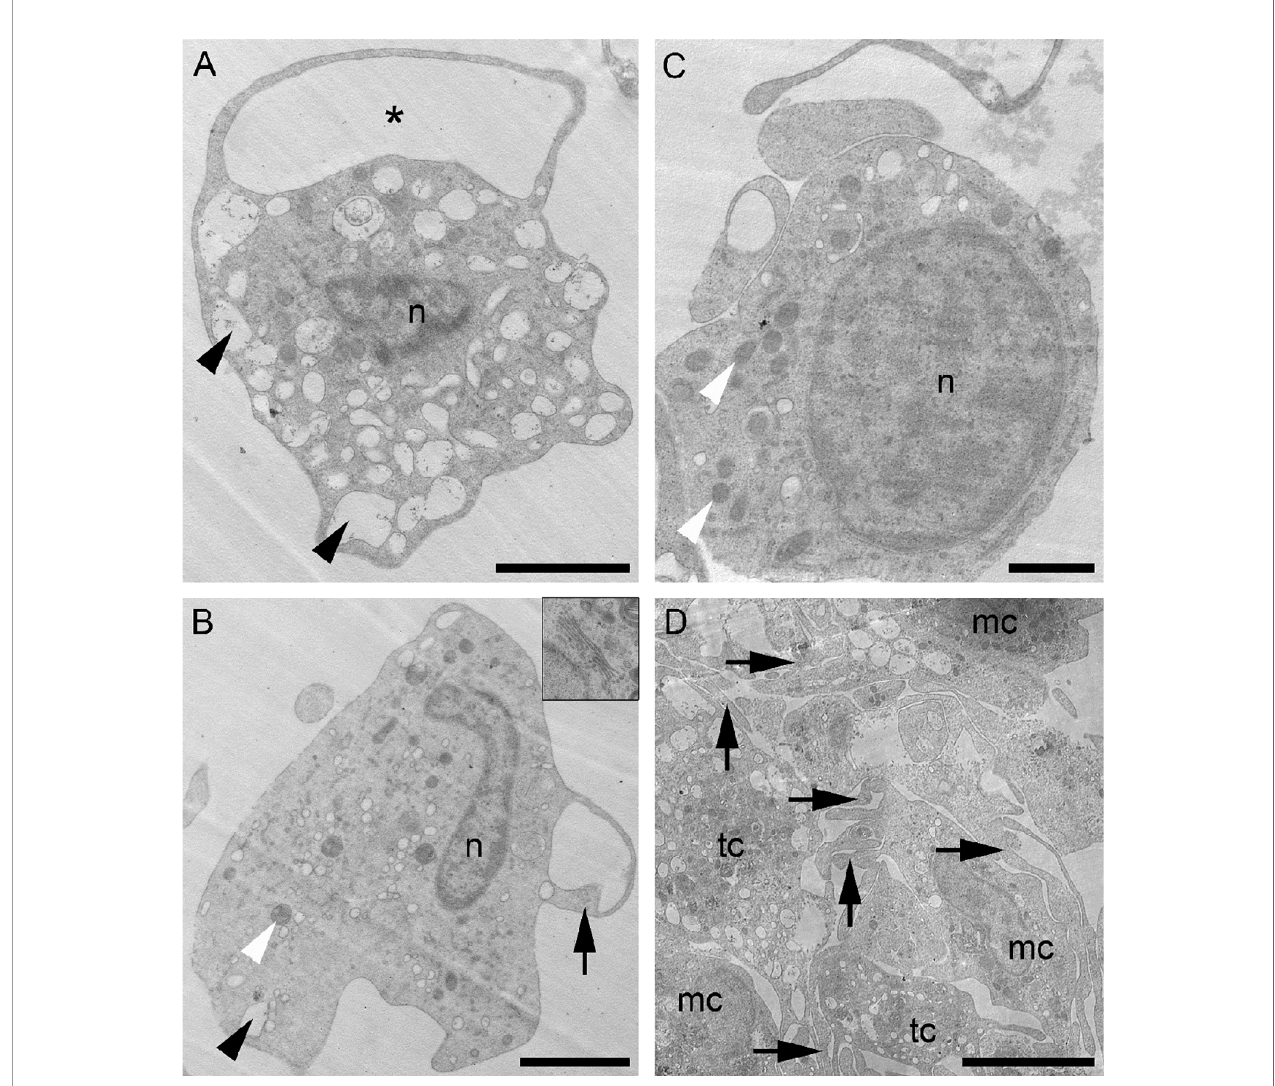
FIGURE 6 | Coelomocytes morphology by transmission electron microscopy. (A) Thrombocyte-like cell (tc) full of roundish electron-lucent vesicles (arrowheads) and with a cell process forming a loop (asterisk). (B) Macrophage-like cell (mc) showing few electron-lucent vesicles (black arrowhead), mitochondria (white arrowhead) and few short cytoplasmic extensions (arrow). A well-developed Golgi apparatus is visible in the top right inset. (C) Slightly undifferentiated cell with a high nucleus/ cytoplasm ratio and several mitochondria (white arrowheads). (D) Aggregate of coelomocytes: both tc and mc possess cytoplasmic processes intermingled with each other (arrows). mc, macrophage-like cell; n, nucleus; tc, thrombocyte-like cell. Scale bars: A, B=2 µm; C=0.5 µm; D=5